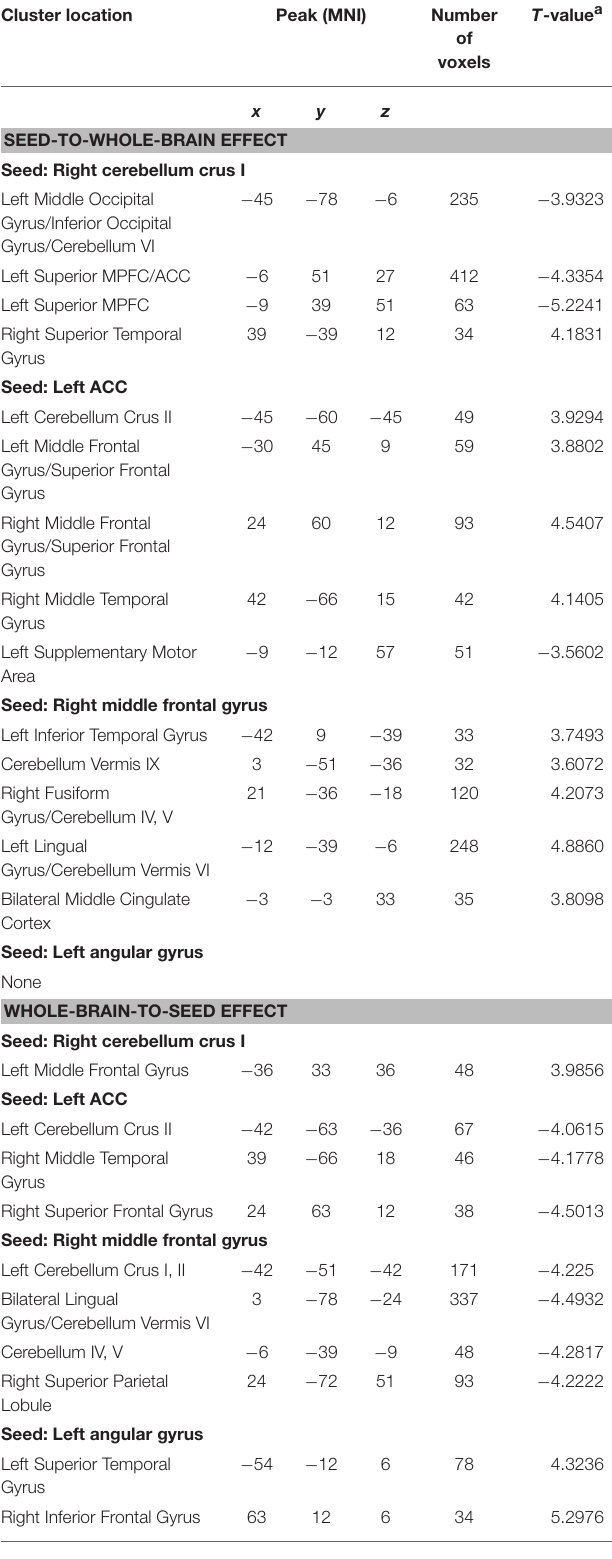
TABLE 3 | Regions with abnormal causal effect with the seeds in the patients. Cluster location Peak (MNI) Number